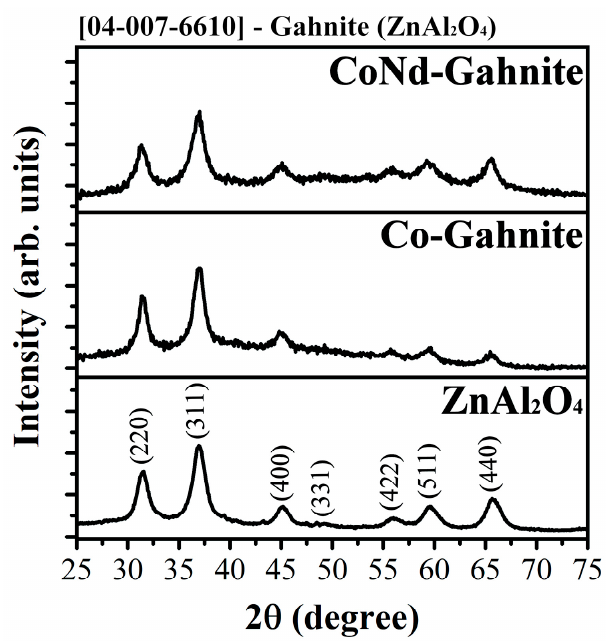
Figure 2. X-ray powder diffraction patterns of ZnAl 2 O 4 (M = Co 2+ and Co 2+ /Nd 3+ ) pigments (showing the Gahnite structure of ZnAl 2 O 4